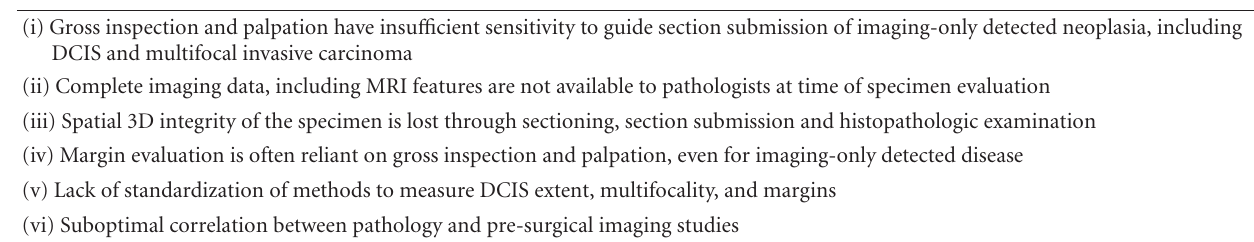
Table 2: Summary of limitations of conventional pathologic technique in the diagnosis and reporting of breast carcinomas in breast-con- serving surgical specimens.